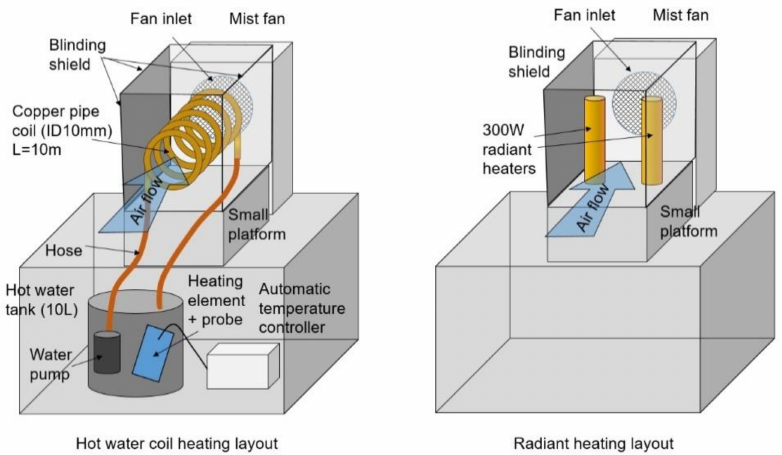
Figure 1. Layouts of heating systems placed behind the visibly misted air stream